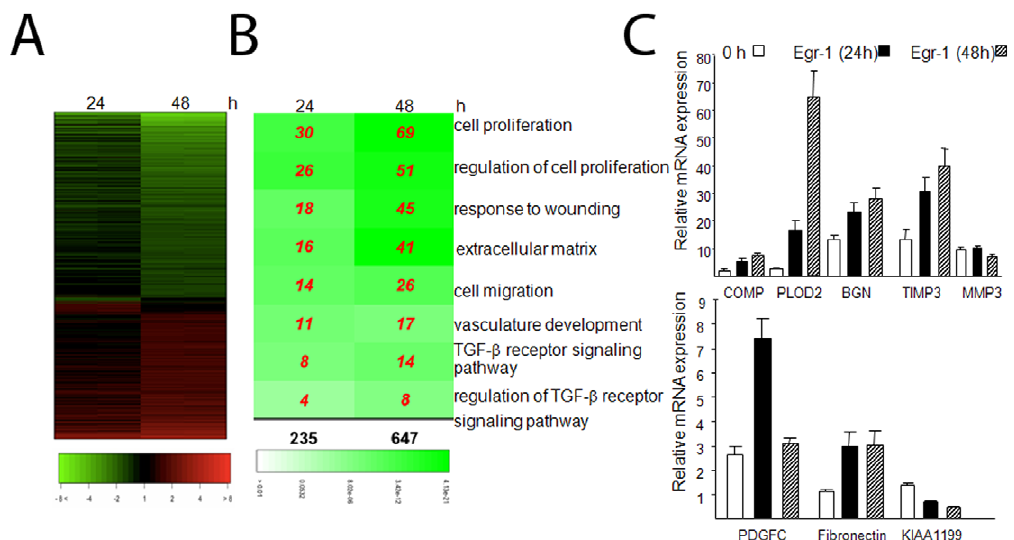
Figure 2. Egr-1-induced transcriptional responses in skin fibroblasts. Dermal fibroblasts were infected with Ad-EGFP or Ad-Egr-1m (100 MOI). At the end of 24 or 48 h incubation, total RNA was isolated and subjected to genome-wide transcriptional analysis using Illumina Microarray chips (A,B) or real-time qPCR (C). A. Heatmap of differentially expressed genes (FDR , 0.01 and . 2- fold-change) (48 h). The color represents the fold- change of Egr-1 in comparison with the average of control sample (red=increased, green=decreased). Each row represents a probe and each column represents one sample. Genes with similar changes in expression pattern compared to the control are clustered together for 24 and 48 h. B. Comparing a subset of biological processes significantly enriched (p , 0.001) with Egr-1-regulated genes at 24 and 48 h. The number in the plot indicates the differentially expressed genes belonging to individual GO categories (row) at corresponding time point (column). The total number of genes at each time point (column) is shown below the Table. The background color represents the statistical significance of a particular biological process overrepresented in the differential gene list as estimated by Hyper-geometric test. C. Real-time qPCR. Results, normalized with GAPDH mRNA, are the means 6 S.D. of triplicate determinations from a representative experiment.